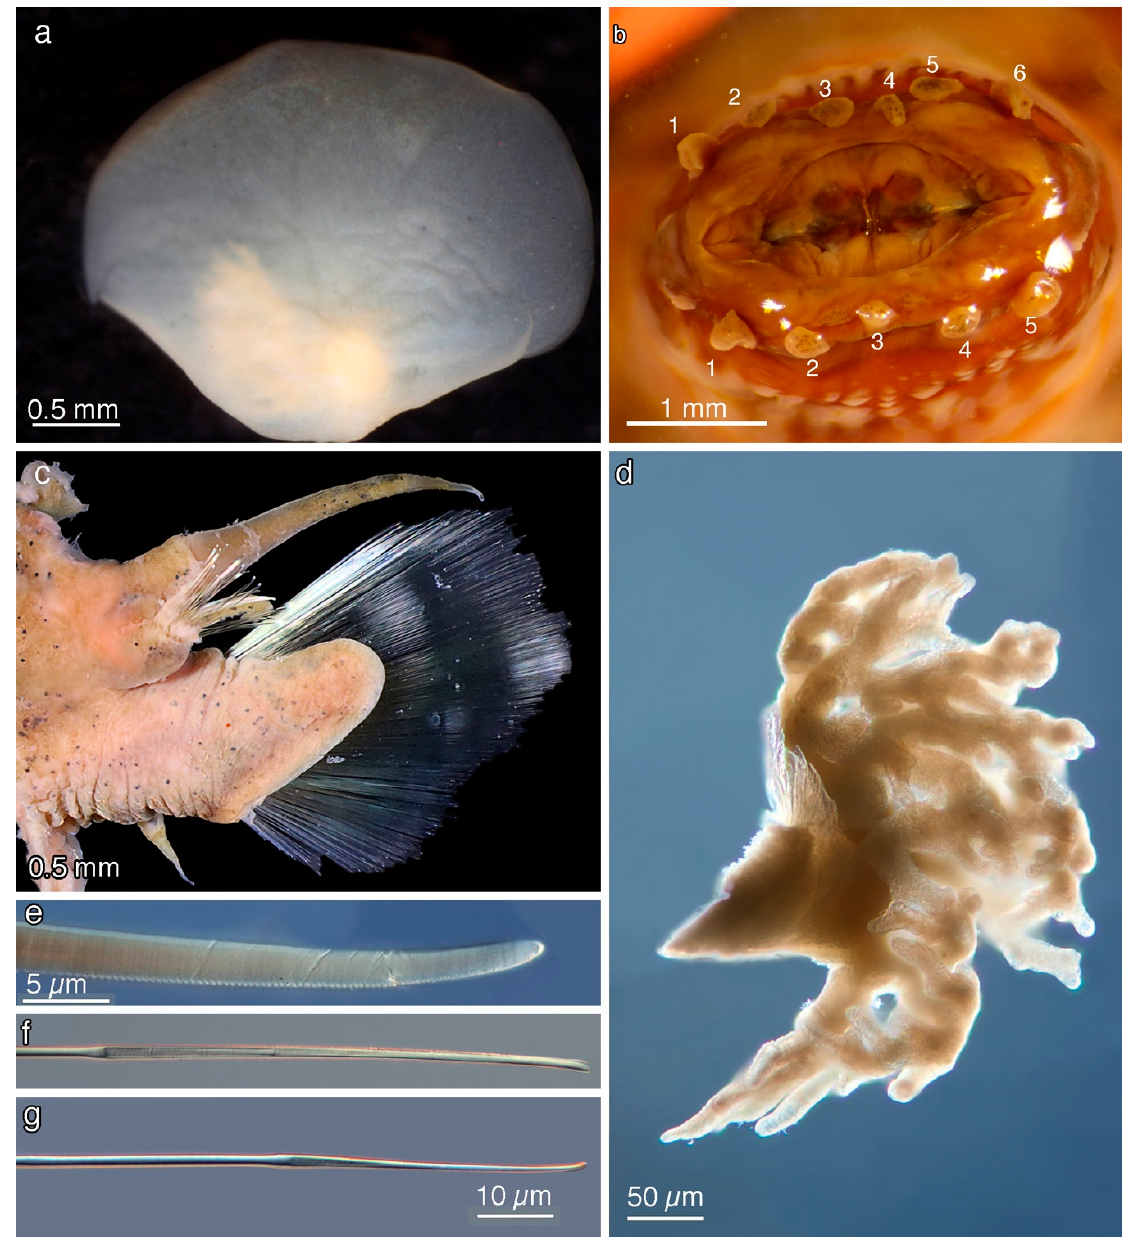
Figure 11. Branchipolynoe halliseyae n. sp. preserved female paratypes (all SIO-BIC A6540, except for proboscis). ( a ) Elytron from Segment 15. ( b ) Frontal view of proboscis showing papillae and jaws (SIO-BIC A6568). ( c ) Parapodium from Segment 14 with dorsal cirrus. ( d ) Branchia from Segment 7 (dorsal group). ( e ) Notochaeta (Segment 16). ( f ) Supra-acicular neurochaetae (Segment 14). ( g ) Subacicular neurochaeta (Segment 14). Same scale for ( f , g ).